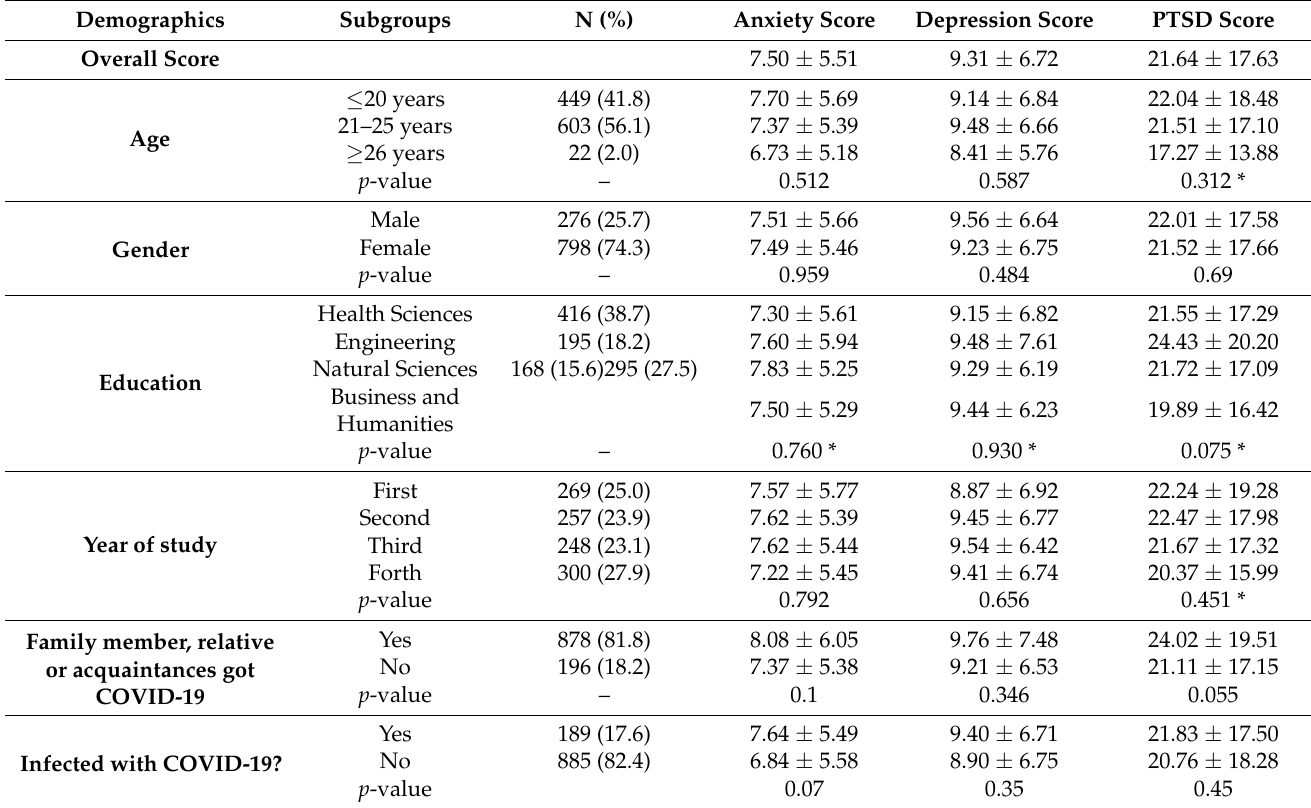
Table 1. Psychological assessment among the study participants and its association with the demo- graphic